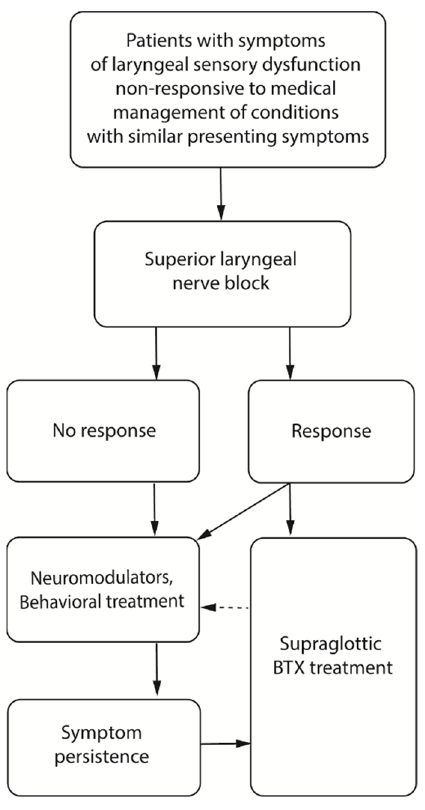
Figure 6. Recommendations of treatment plans for patients with LSD.